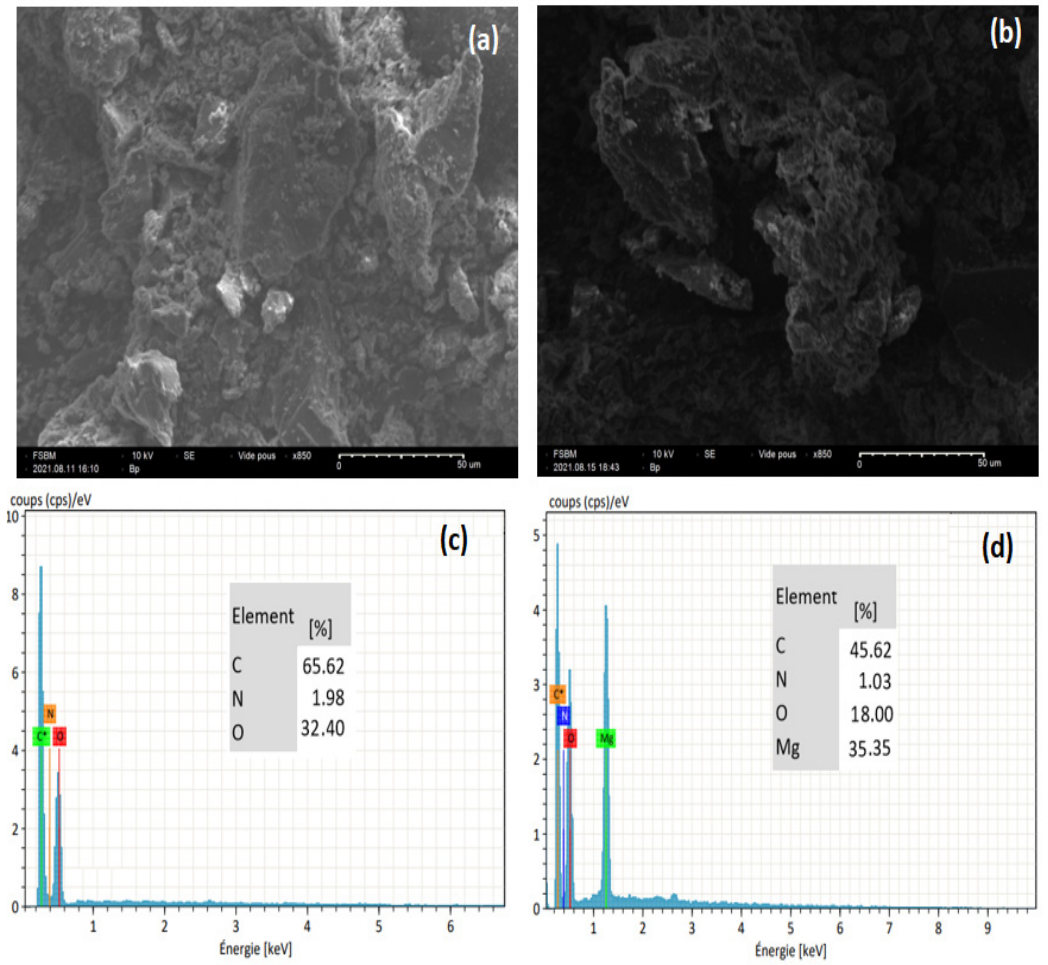
Figure 2. SEM images of CHt ( a ) and CHt@MgO ( b ); elemental analysis plots of CHt ( c ) and CHt@MgO ( d ).